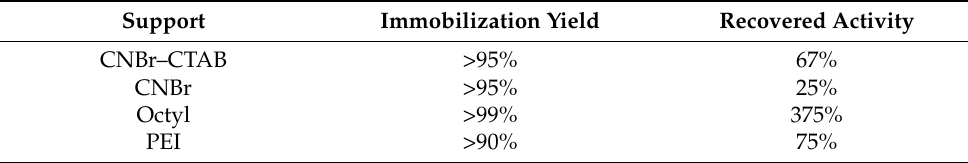
Table 2. Preparation of different immobilized derivatives of